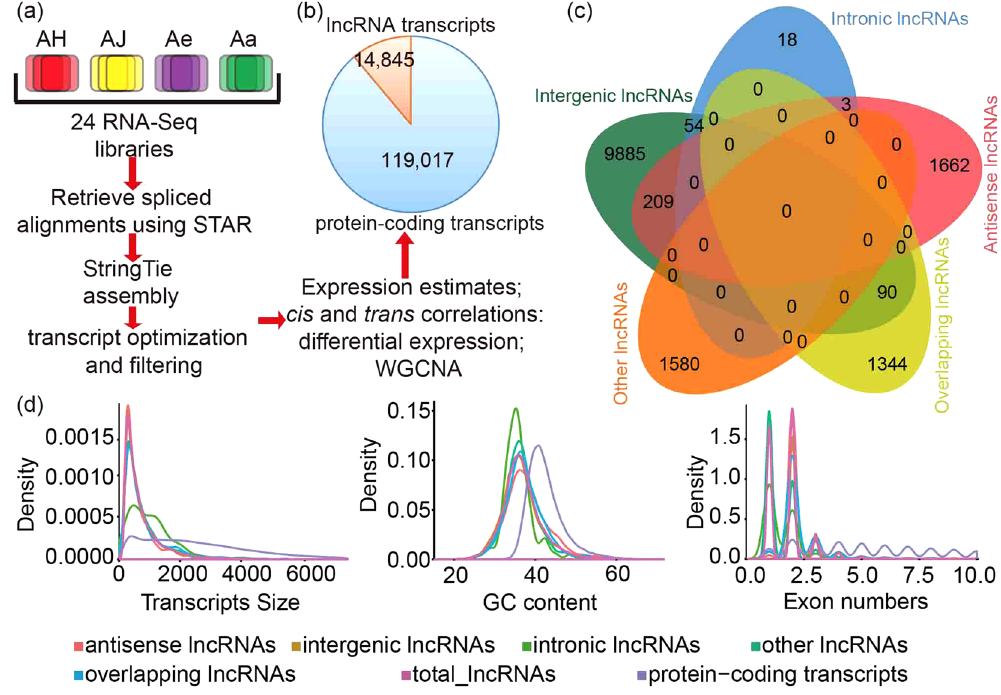
Figure 2. Overview of kiwifruit transcriptomes and characteristics of lncRNAs. ( a ) Samples and pipeline for transcriptomic analyses. ( b ) Total number of protein-coding transcripts and lncRNAs. ( c ) Venn distribution of different lncRNA types. ( d ) Density distribution of transcript length, GC content and exon number for both protein-coding and lncRNA